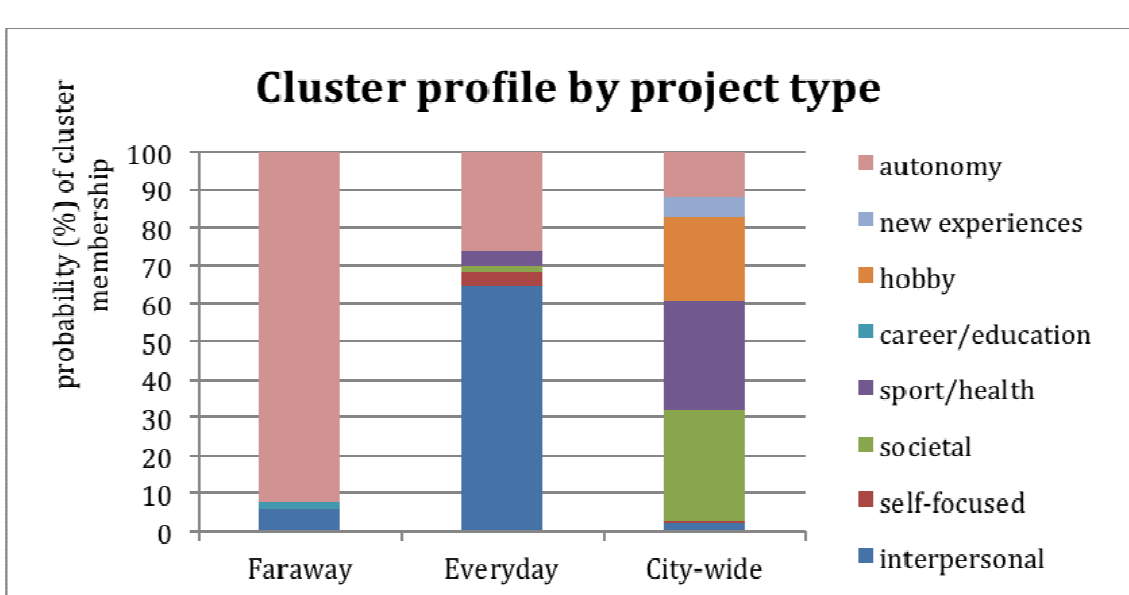
Figure 3. Cluster membership based on project